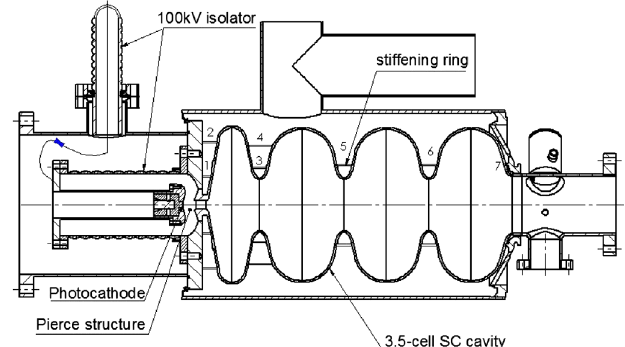
FIG. 2. Key components of the DC-SRF injector.